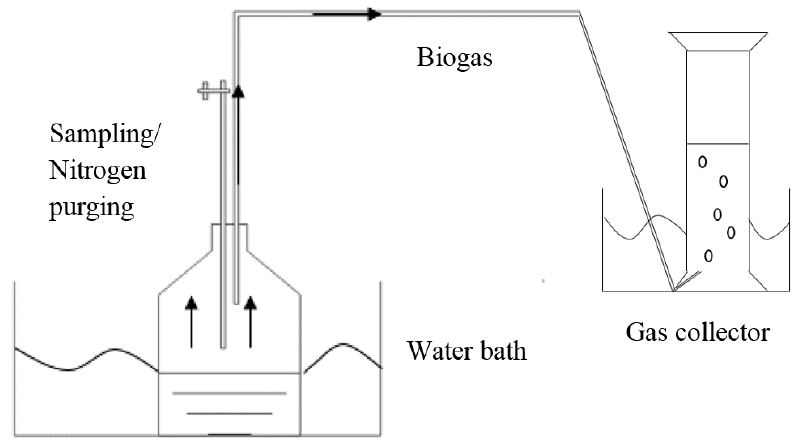
Figure 1. Schematic diagram of the anaerobic digestion process.